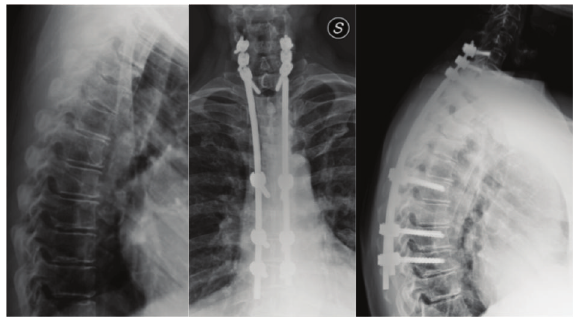
Figure 3: A 65-year-old female. Metastasis of breast cancer of T2-T3-T4. To limit the invasiveness of a completely open surgical approach, a hybrid long construct was carried out (percutaneous from T9-8 to T6 and open from T1, C7-6) using a double diameter rod.